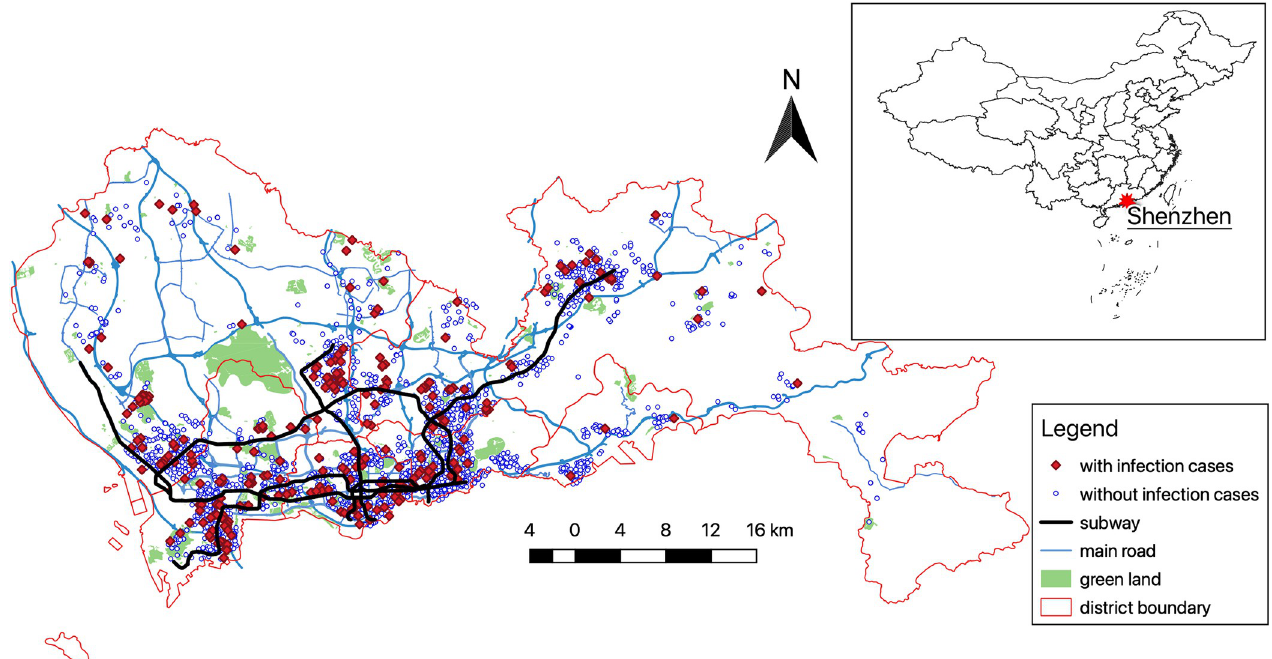
Fig 2. Neighborhoods with and without COVID-19 cases in